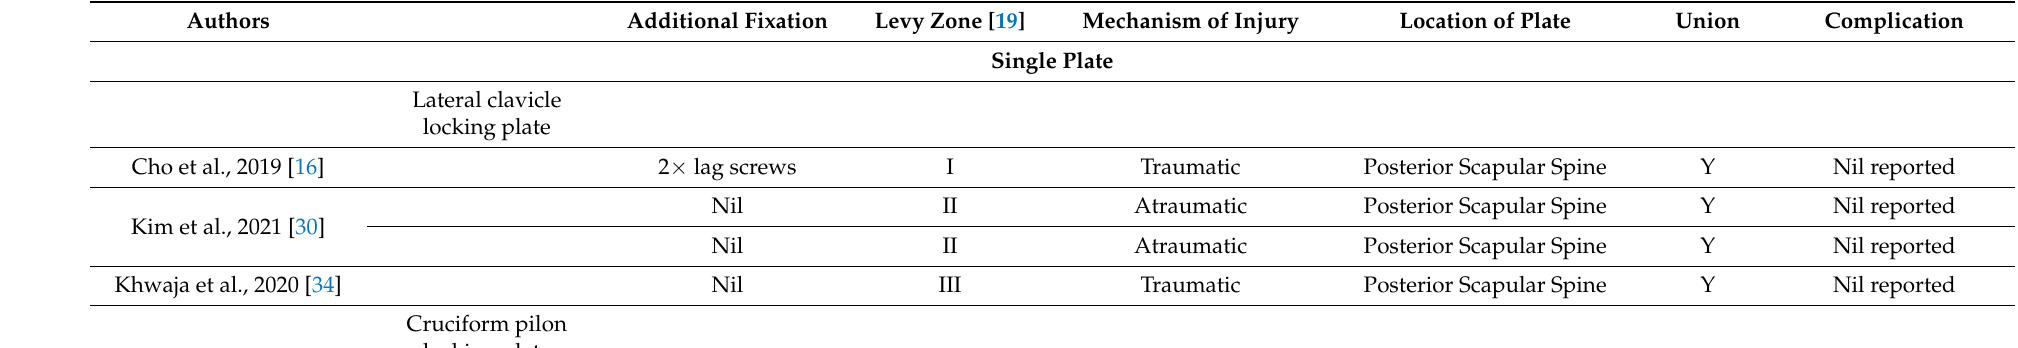
Table 3. Fracture location, union and complications stratified by fixation